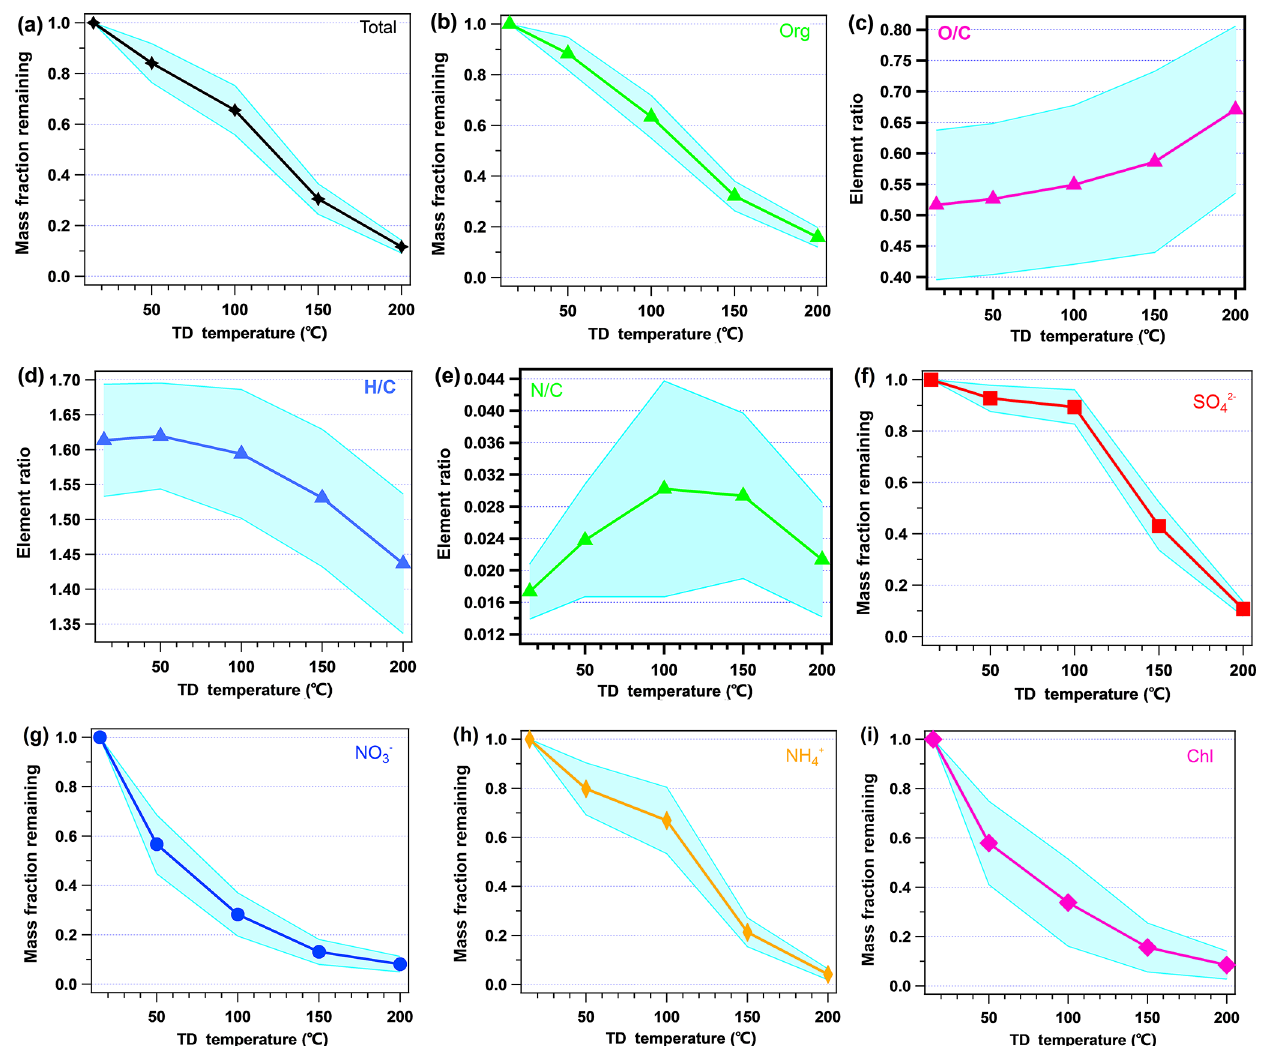
Figure 5. Variation in the average mass fraction remaining (MFR) of the total of non-refractory species and the ratios of O / C, H / C, and N / C with the TD temperature. The shaded regions indicate the average ±